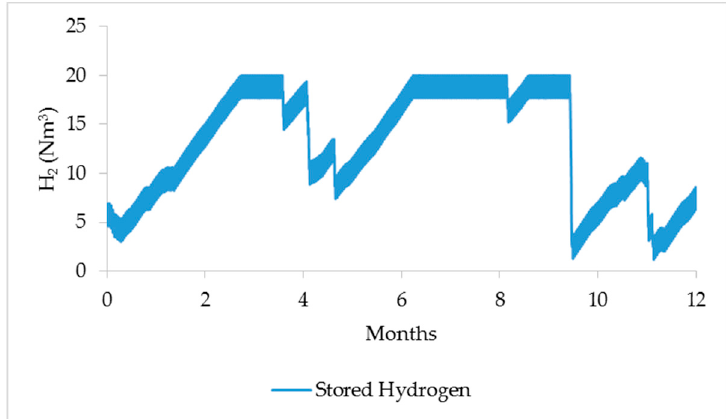
Figure 8. Hydrogen in the metal hydride tank during the year.